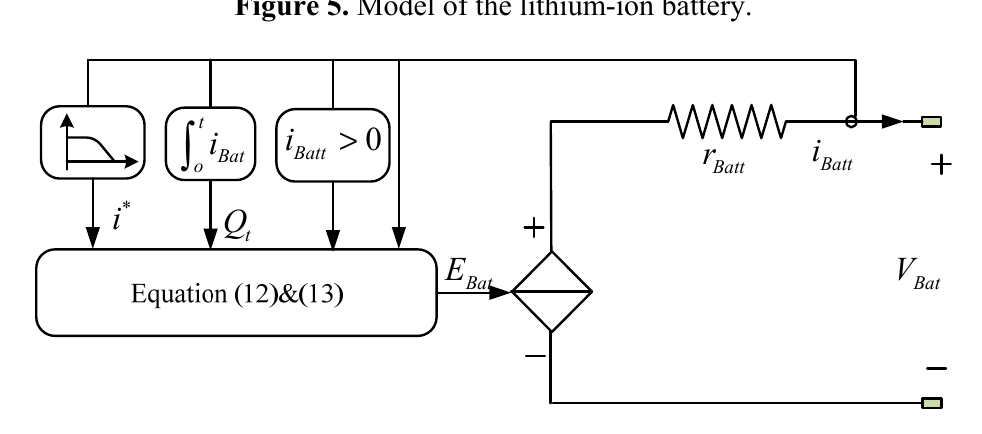
Figure 5. Model of the lithium-ion